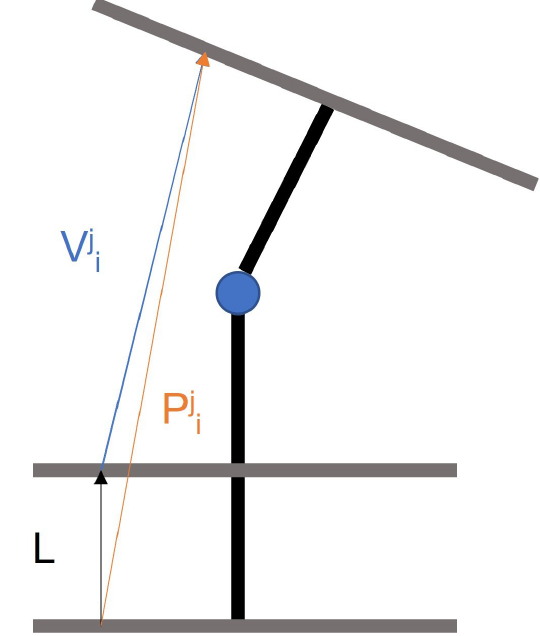
Figure 25. Geometrical reasoning for cables’